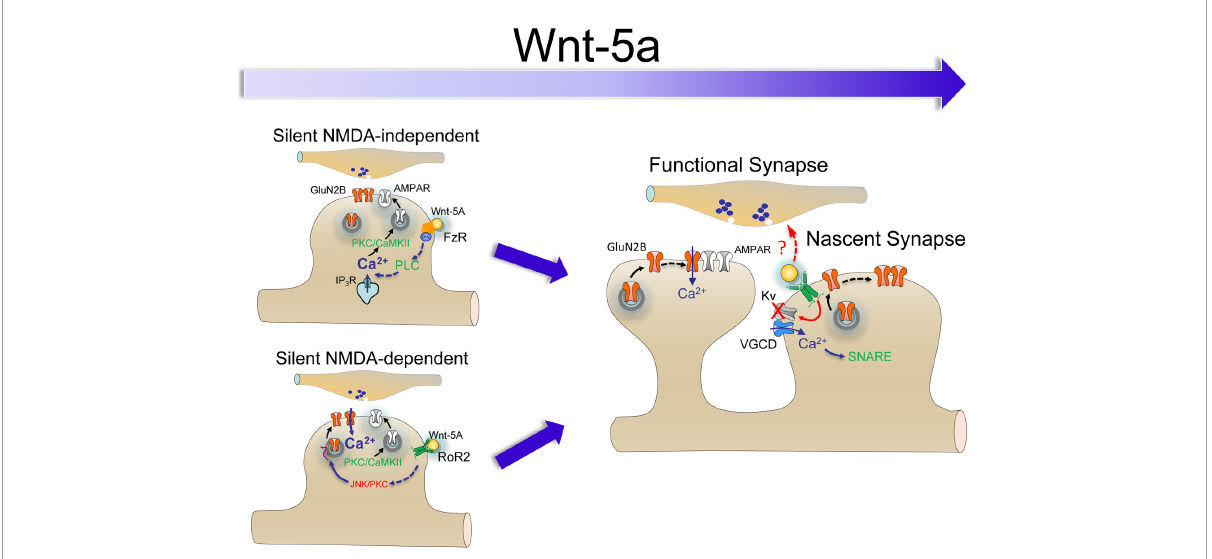
FIGURE4 Putative cascades of Wnt-5a-induced conversion of silent synapses. There are two possible activation mechanisms: (1) NMDAR-independent activation or conversion, initiated by FzR activation, promoting Ca 2 + release by PLC activation, and (2) NMDAR-dependent activation or non-conversion, initiated by RoR2 activation, which increases I NMDA by PKC and JNK activation and, in turn, increases the intracellular Ca 2 + concentration. At longer exposure times, RoR2 activation induces depolarization, activating voltage-gated Ca 2 + channels and, in turn, triggering SNARE-dependent trafficking of NMDARs and promoting the emergence of a nascent